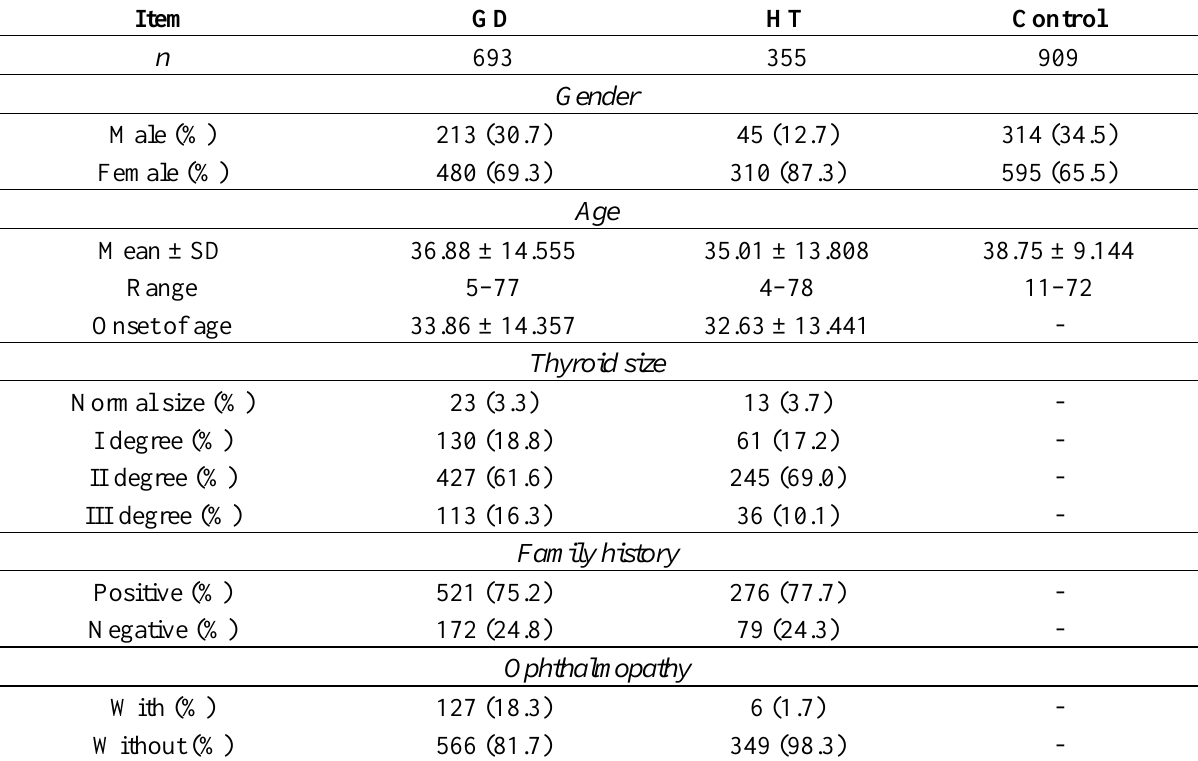
Table 8. Demographic characteristics of the AITD patients and